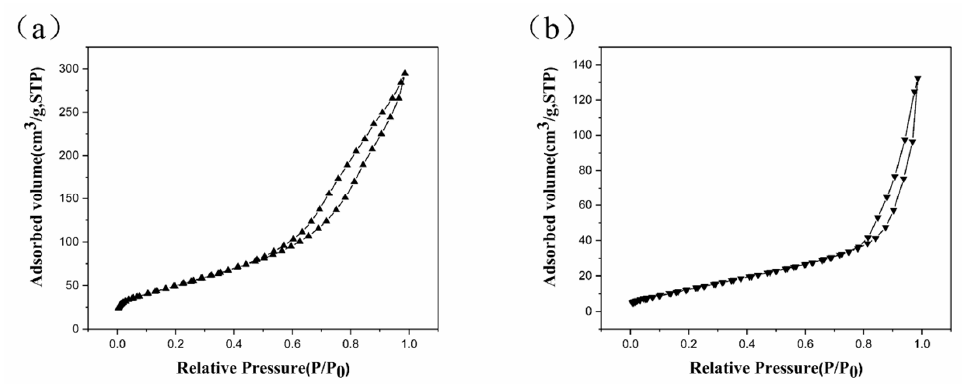
Figure 4. N 2 adsorption isothermal diagram of ( a ) sample T2 and ( b ) sample T4.